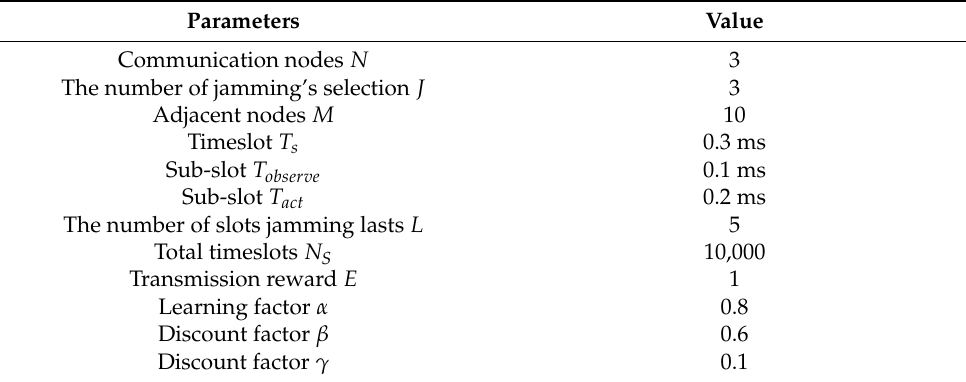
Table 1. Settings of model-related parameters.